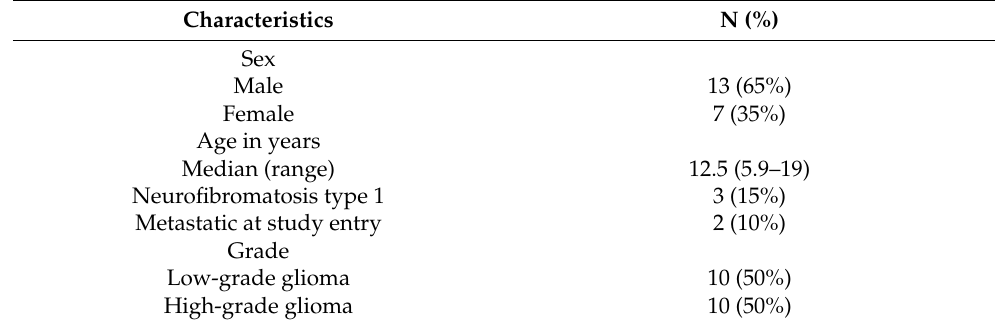
Table 1. Characteristics of the 20